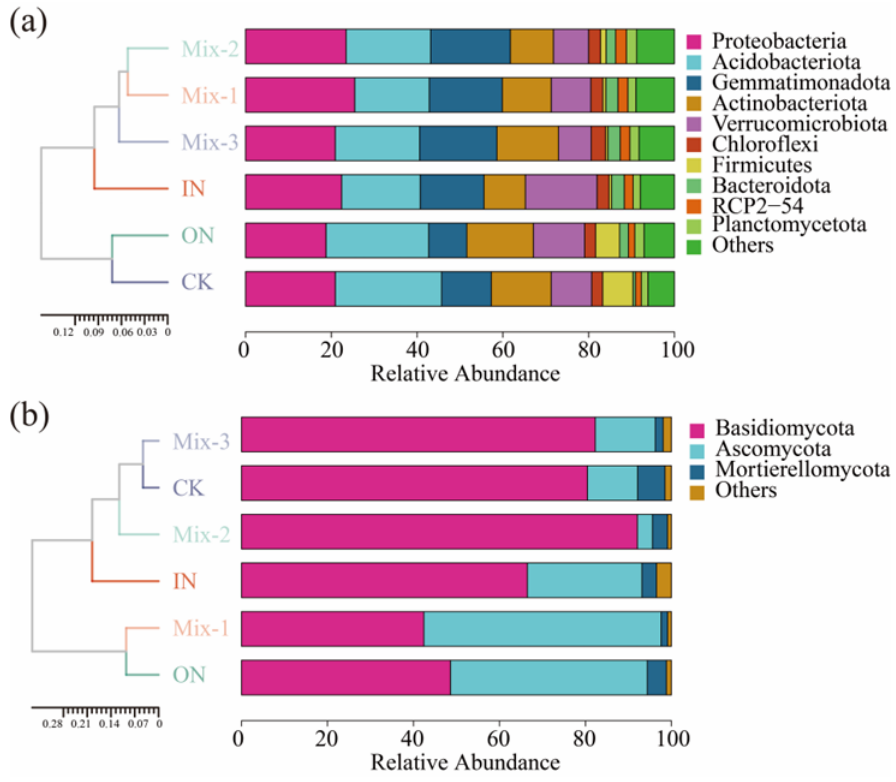
Figure 2. The relative abundance of bacteria ( a ) and fungi ( b ) at the phylum level based on the results of clustering analysis.